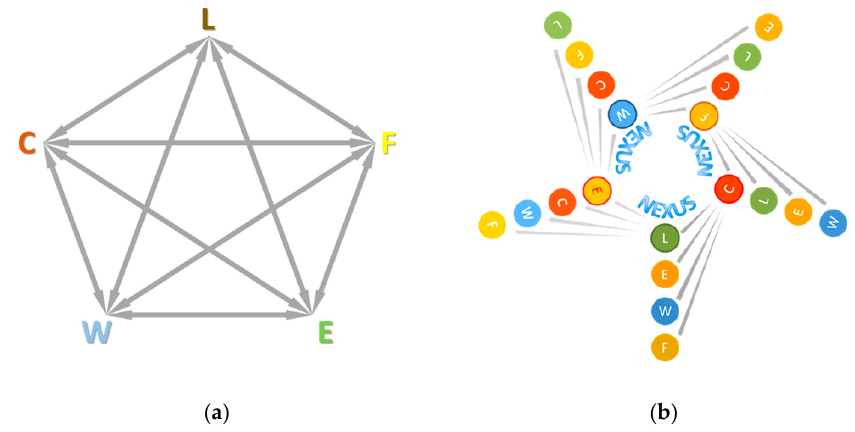
Figure 1. ( a ) Nexus component interlinkages, showing all interrelations between different nexus components; ( b ) Schematic of nexus component interlinkages, showing how each one of the five nexus components relate to the other four.